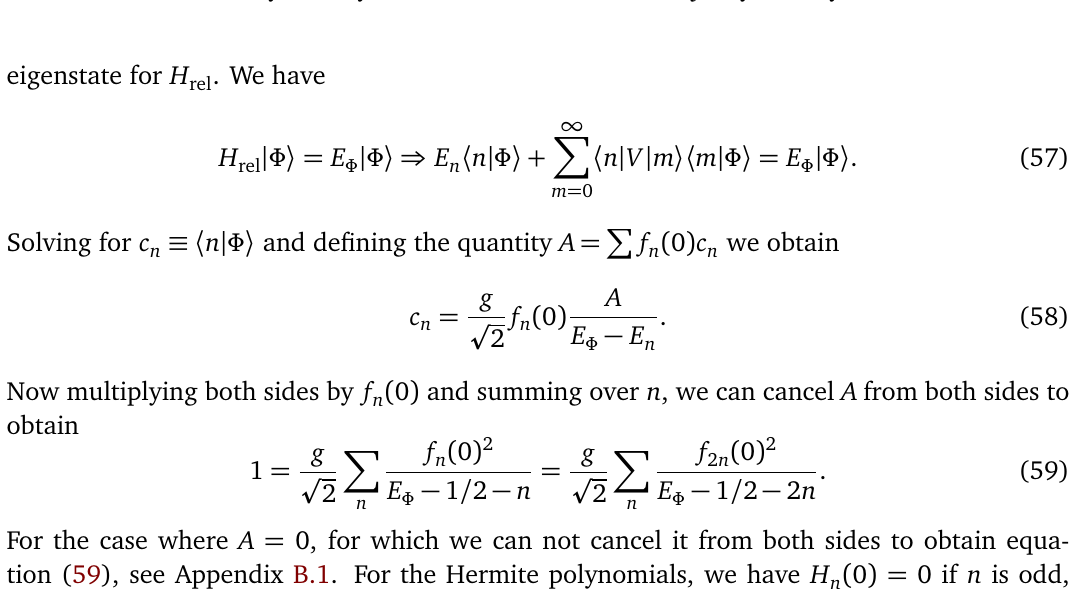
Figure 12: Position space density for the ground state at g well potential in Figure 1 for the 6 + 1 system. The density profile localized in the left well is the minority density and the other one is the majority